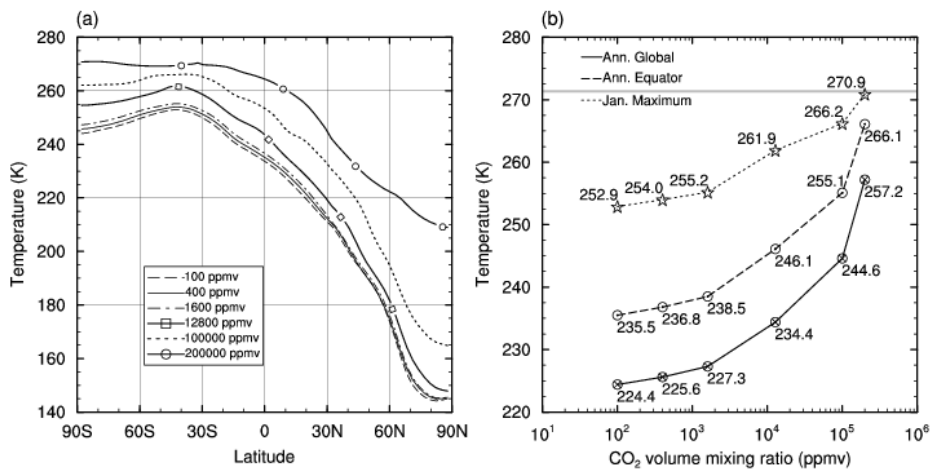
Figure 7. Same as Figure 1, except for that the contribution of CO Fig. 7. Same as Fig. 1, except for that the contribution of CO 2 partial pressure to total pressure and the effect of pressure-broadening are total pressure and the effect of pressure-broadening are considered.